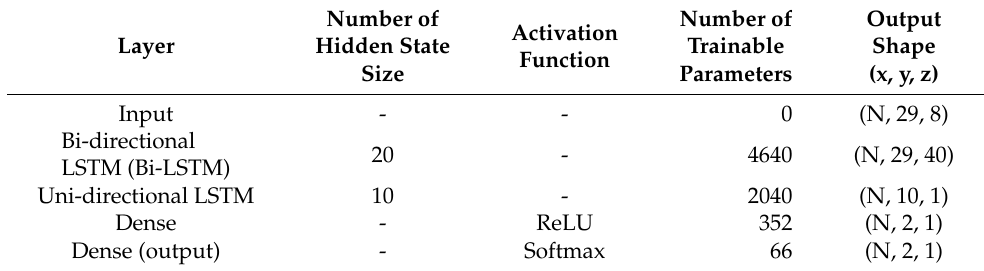
Table 4. Detailed settings of the proposed RNN